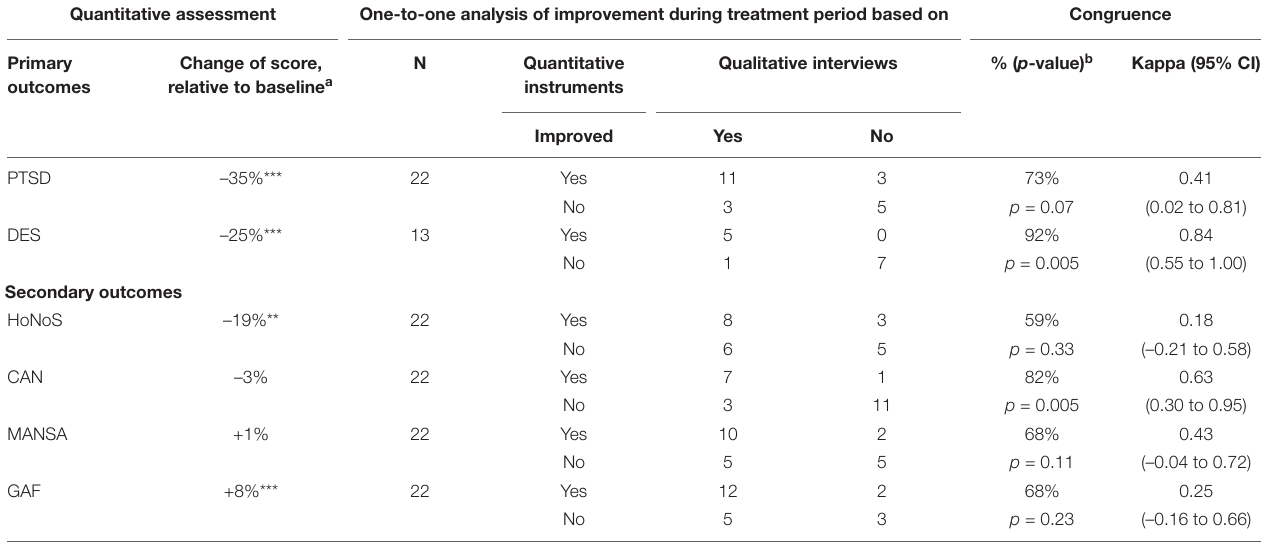
TABLE 3 | Congruency between quantitative and qualitative